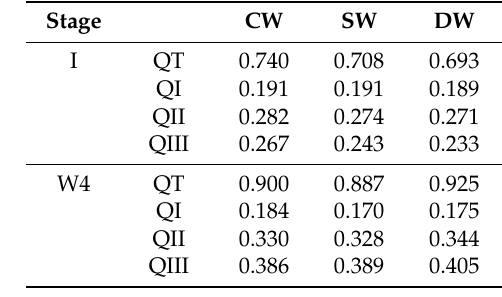
Table 3. Values of the area under the curve (QT, QI, QII, and QIII) extracted from the cyclic voltammetry curves of the red wines at stage I and W4.